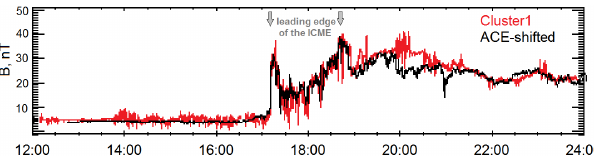
Figure 4. The interplanetary magnetic field strength measured by ACE (black) and Cluster 1 (red) during the passage of the high- speed ICME on 21 January 2005. ACE 16s resolution data are shifted to the Cluster 1 position. The leading edge region filled with current sheets is indicated by